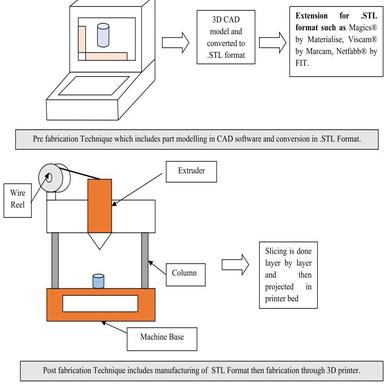
Pre fabrication and post fabrication steps in additive manufacturing.